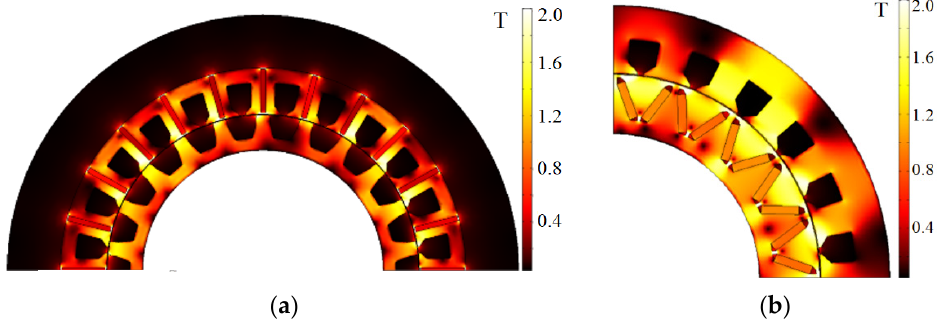
Figure 5. Initial design and magnetic flux density at the rated mode: ( a ) PMFSG; ( b ) IPMSG. Table 7. Characteristics of the PMFSG and IPMSG initial